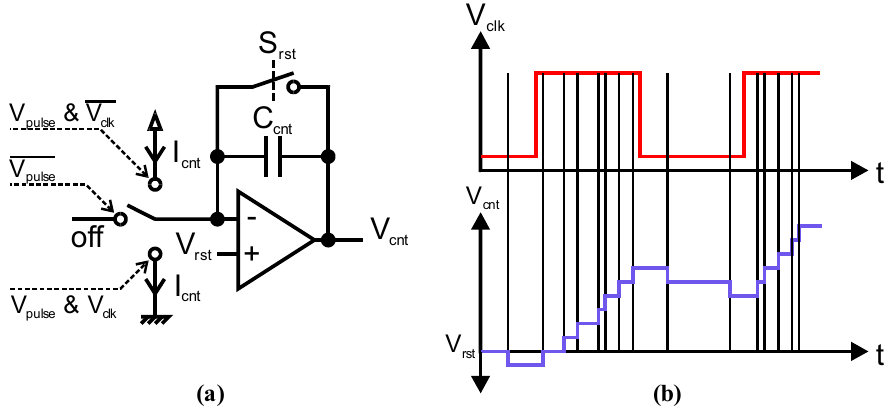
Figure 1. ( a ) Schematic of an integrator-based analog correlator circuit. Logic combinations for the different switch positions are depicted with dashed lines; ( b ) integration of photon pulses and V clk over time t with photon pulses marked as vertical black lines.